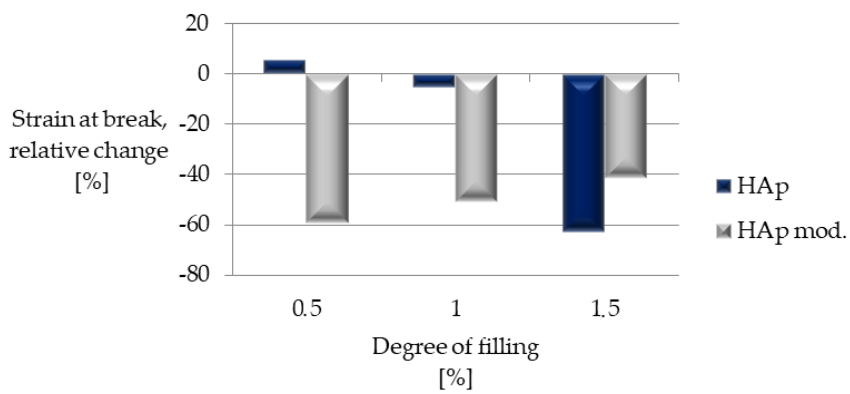
Figure 22. Relative change in strain at break with respect to unfilled PLA.